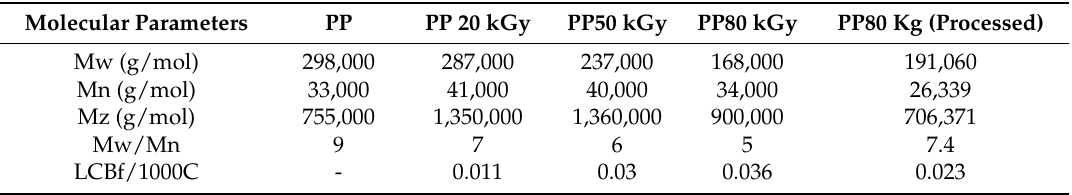
Table 1. Molecular parameters including LCB density evaluated using SEC Chromatography coupled with three detectors of non-irradiated, irradiated PP and processed irradiated PP.